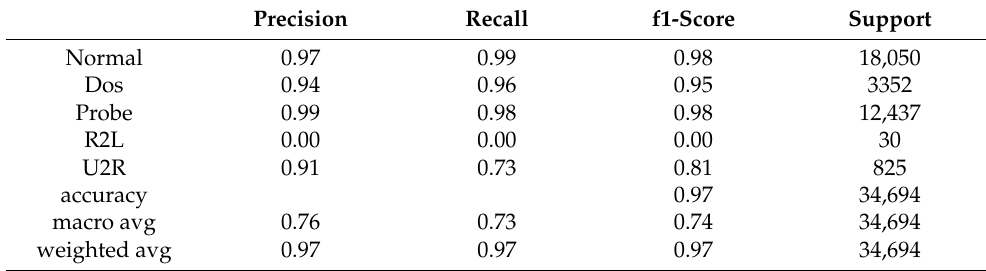
Table 5. Validation metrics of the CNN